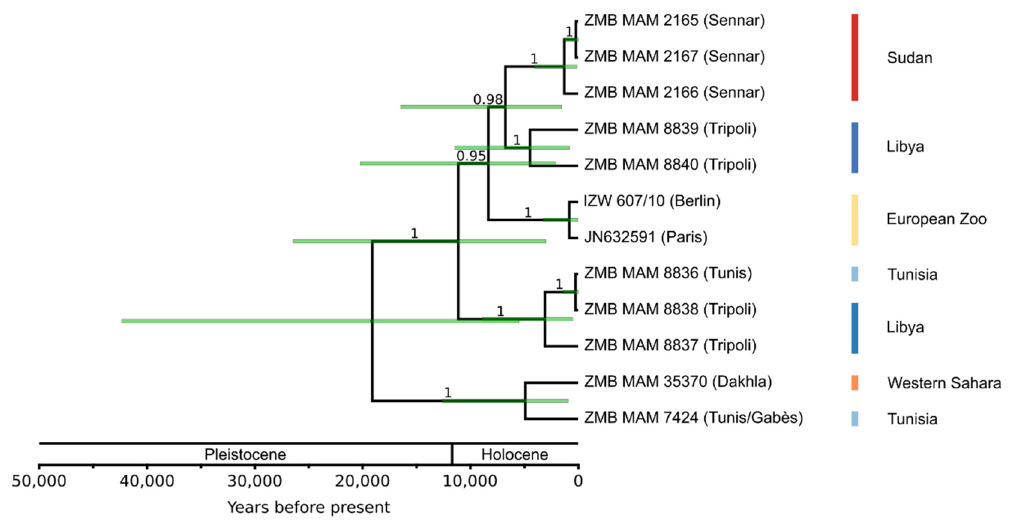
Figure 5. Secondarily calibrated Bayesian phylogeny of twelve addax mitochondrial genomes. The root age was cali- brated using the age estimate from the Bayesian mitochondrial species phylogeny (Figure 4). Branch values show posterior probabilities, light green node bars represent 95% credibility intervals of divergence times. The lower genetic variability among addax specimens resulted in large uncertainty of node ages.